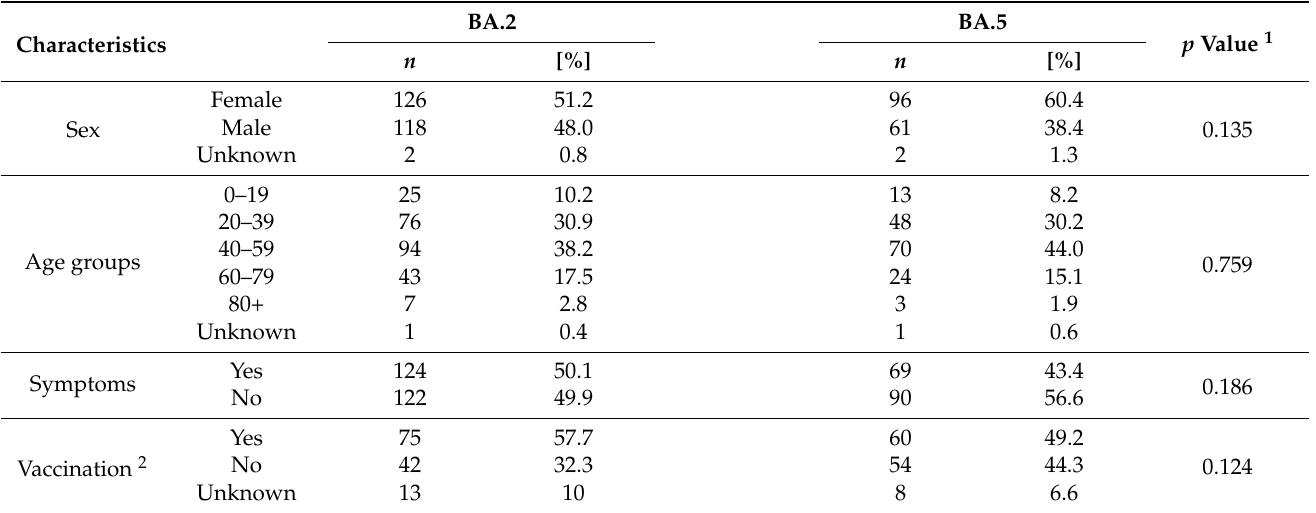
Table 1. Epidemiological characteristics and analyses on information from recorded BA.2 and BA.5 cases.